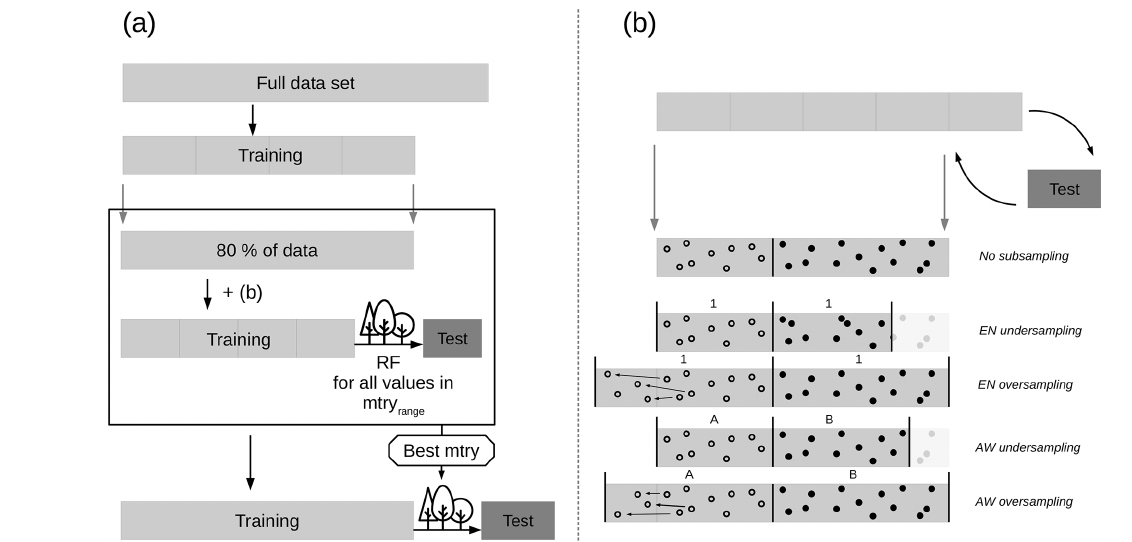
Figure 4. Nested k -fold CV approach for model tuning and evaluation. General approach without data subsampling (a) . Incorporation of the subsampling strategies in the CV approach (b) .